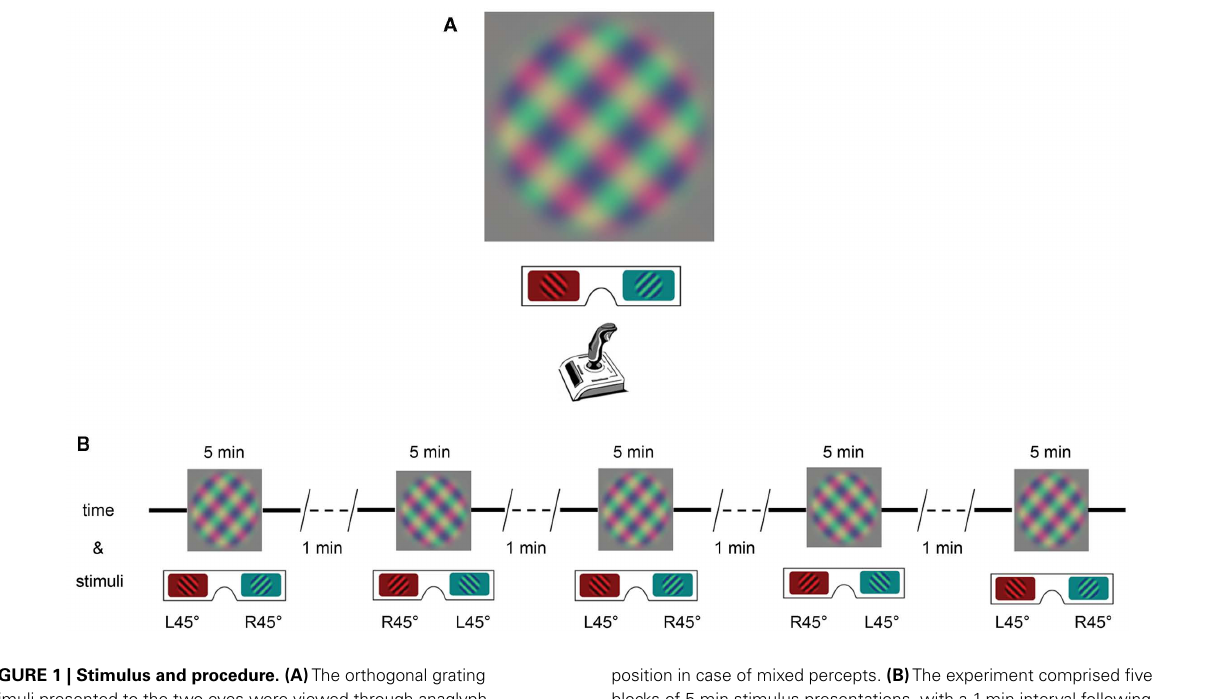
FIGURE 1 | Stimulus and procedure. (A) The orthogonal grating stimuli presented to the two eyes were viewed through anaglyph glasses. Subjects had to indicate the tilt of the perceived grid by tilting the joystick correspondingly.They kept the joystick in the center